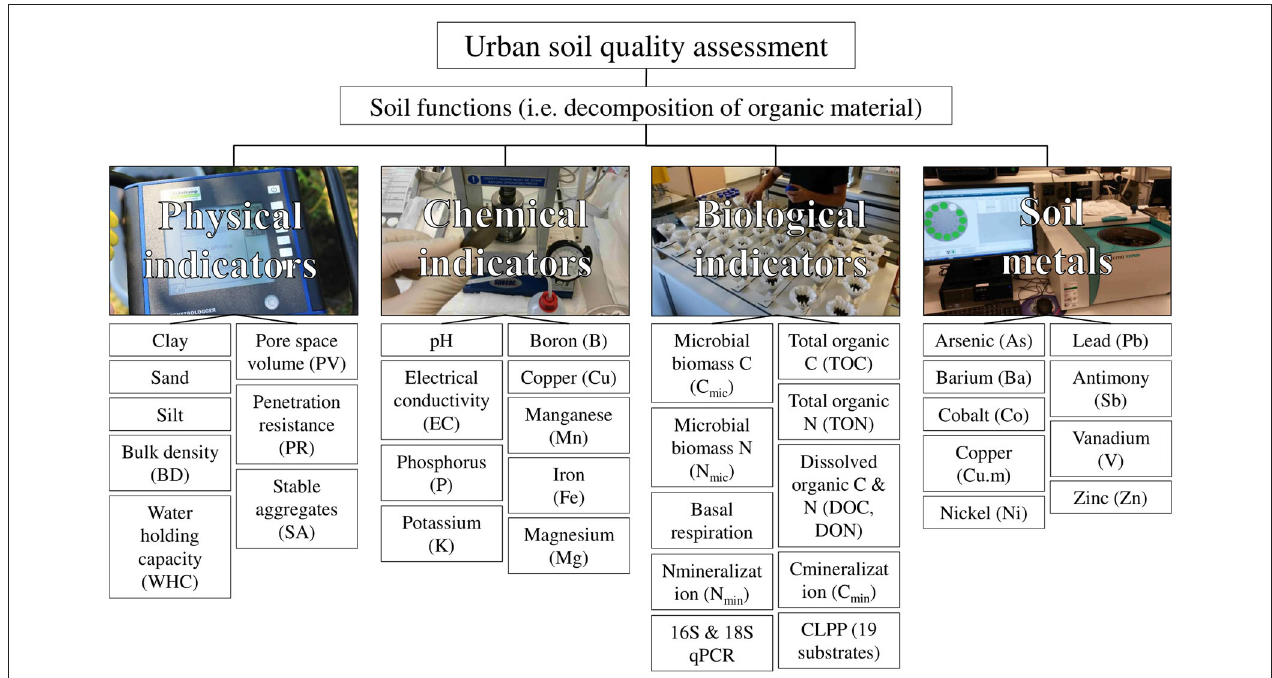
FIGURE 1 | Concept of assessing urban soil quality through the measurements of soil quality indicators related to soil functions. Details about soil quality indicators measured in urban gardens of Zurich, Switzerland can be found in Table S4 .